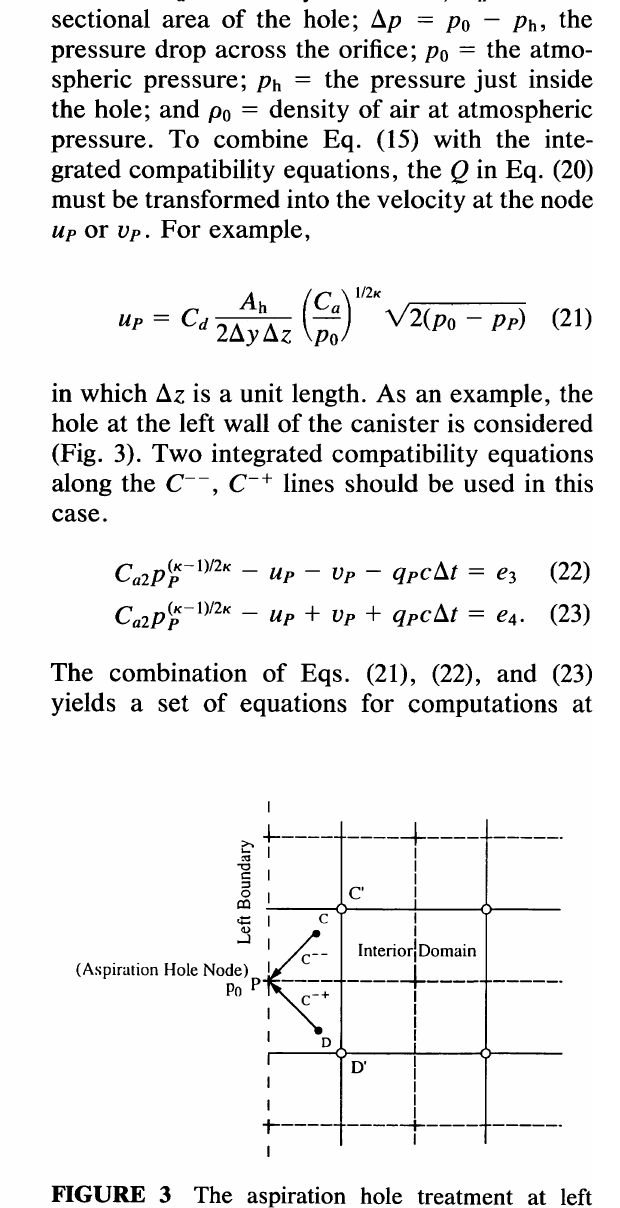
FIGURE 2 Path lines in x-y-t space.